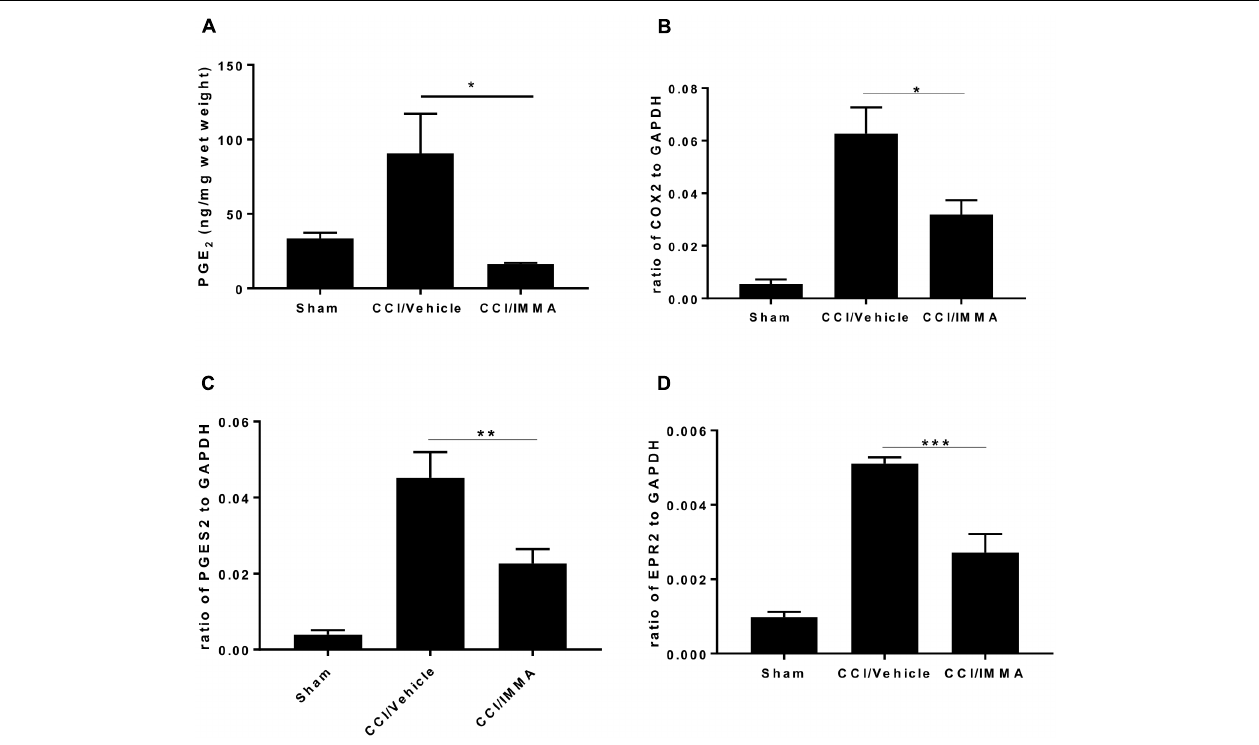
FIGURE 7 | IMMA treatment reduced PGE 2 synthesis in the CCI mouse ipsilateral sciatic nerve. PGE 2 production was measured by ELISA with the fresh sciatic nerves from mice 7 days post-CCI. Significantly increased PGE 2 production in the CCI/vehicle group was remarkably attenuated by IMMA treatment (A) . The mRNA expression of enzymes contributing to the PGE 2 synthesis, COX-2 (B) and PGES2 (C) , were greatly increased in CCI/vehicle group and reduced by IMMA. The increased expression of EP2 receptor in the CCI/vehicle mice was also attenuated by IMMA treatment (D) . ∗ p < 0.05, ∗∗ p < 0.01, and ∗∗∗ p < 0.001 were obtained when the CCI/vehicle group was compared to the IMMA treated group ( n = 10/group). One-way ANOVA was used for comparing the differences among the sham, vehicle and IMMA treated groups. The Tukey-Kramer post hoc test was used for the